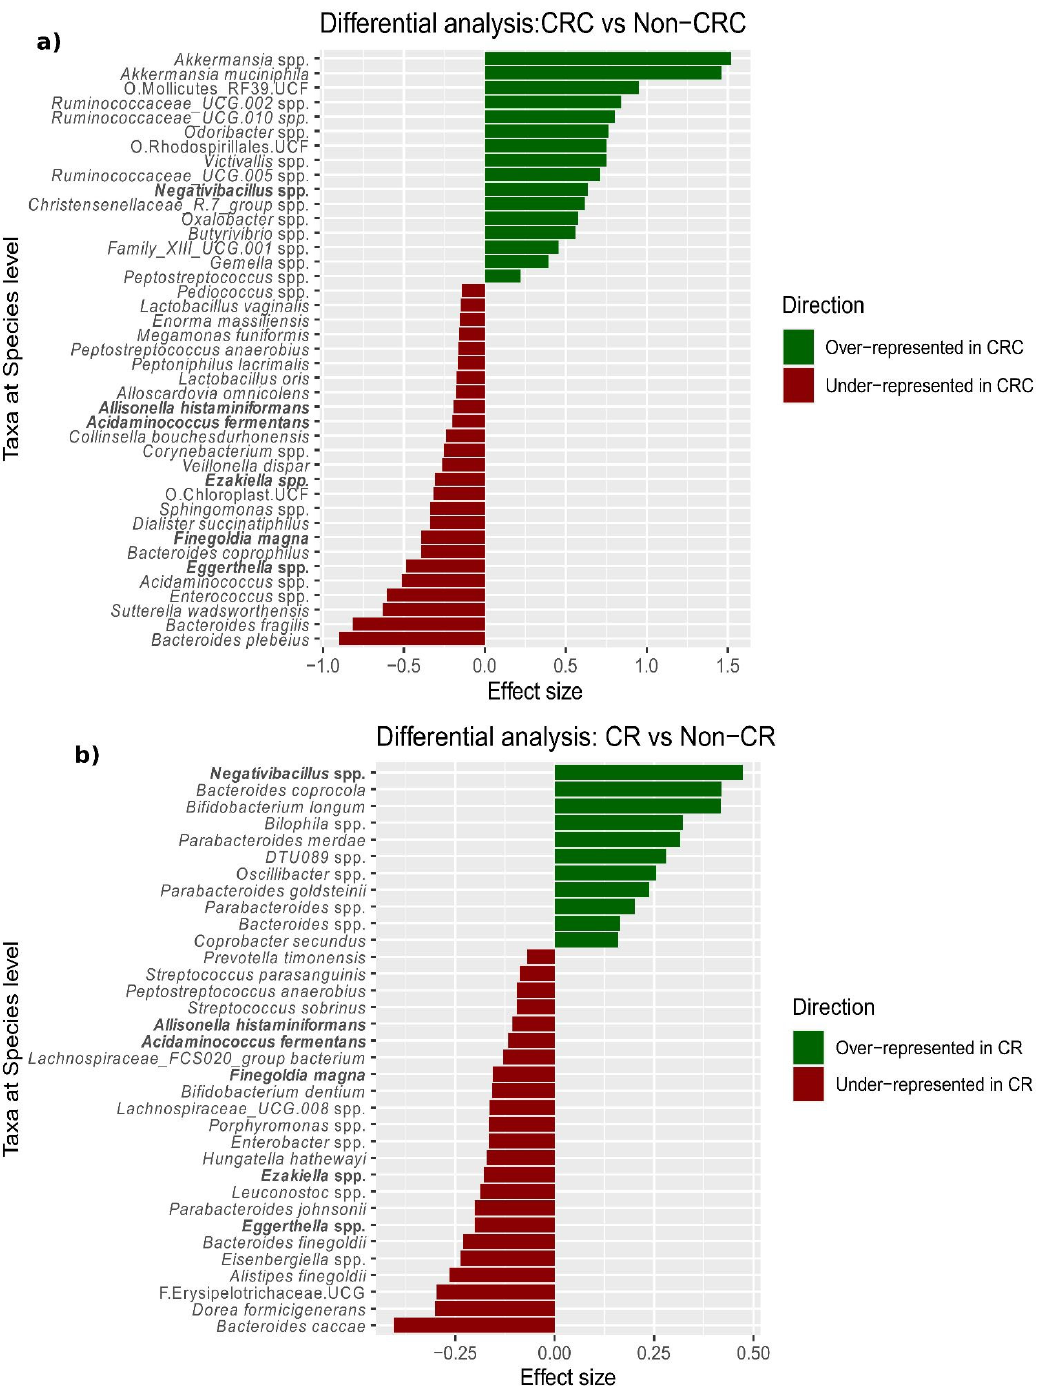
Figure 2. The effect size of species found as significantly differentially abundant when comparing CRC vs. non-CRC samples (n = 2565) ( a ) and CR vs. non-CR samples ( b ). Bars are green for overrepresentation and red for underrepresentation. The bars are sorted according to the effect size. In bold are the highlighted taxa that appeared as differentially abundant in both comparisons.